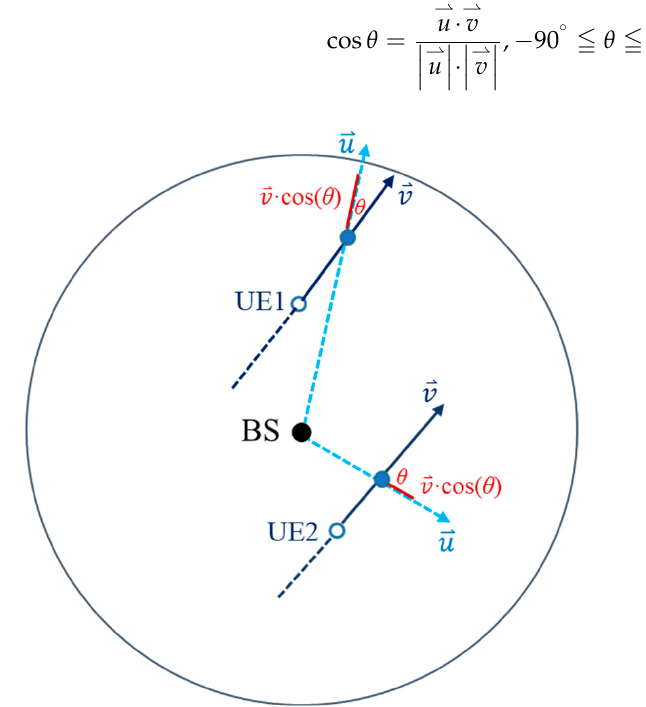
Figure 4. Illustration of the horizontal moving speed of UE.